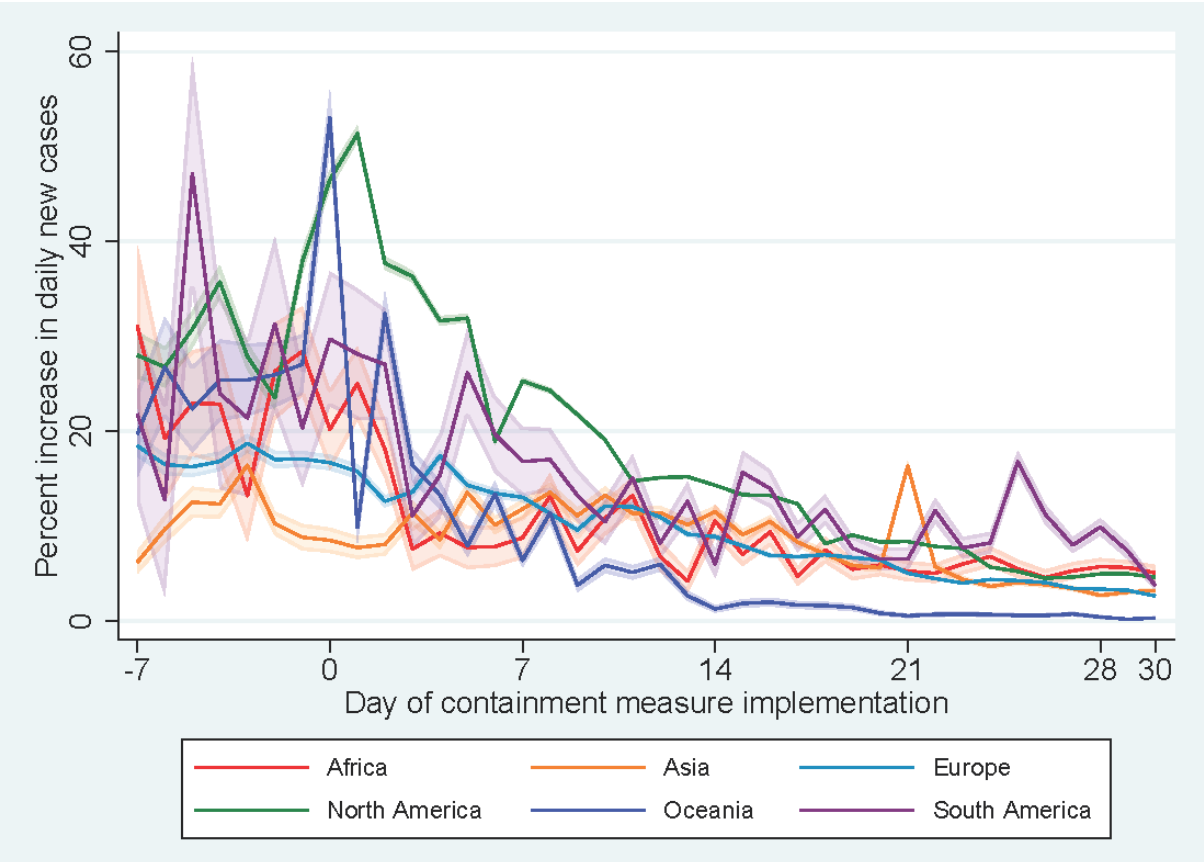
Figure 3. Percent increases in daily new cases against days since implementation of containment measures by